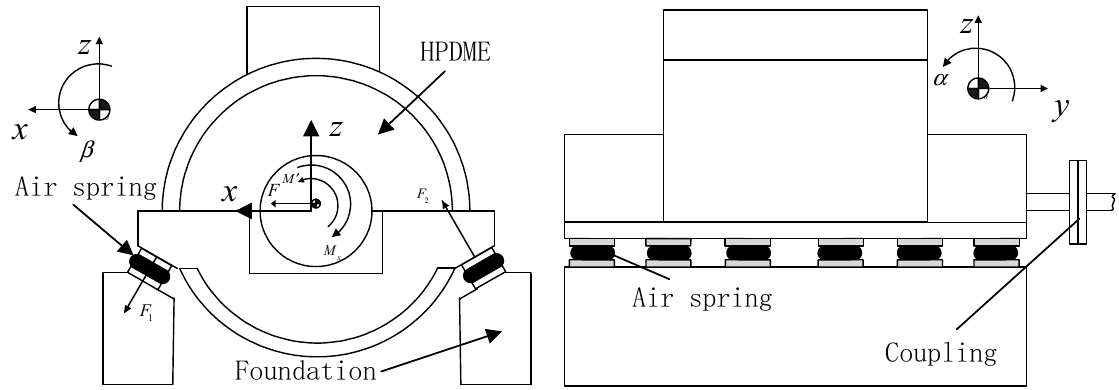
Figure 1. Schematic diagram of HPDME-ASVIS. The air springs are arranged symmetrically with respect to the yoz plane and the xoz plane at the same height. The main engine and foundation are treated as rigid